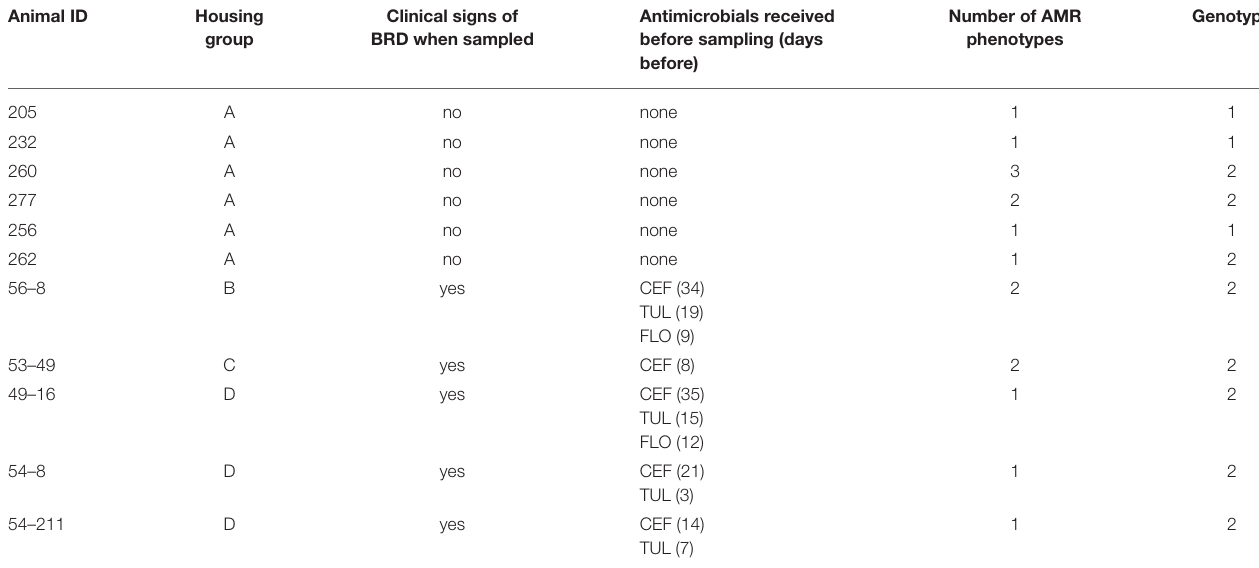
TABLE 1 | Information regarding cattle from which Mannheimia haemolytica ( M. haemolytica ) was isolated from nasopharyngeal swabs (NPS), the number of AMR phenotypes (antibiograms) of M. haemolytica identified among all isolates, and the genotype of M. haemolytica isolated based on MALDI-TOF MS. Animal